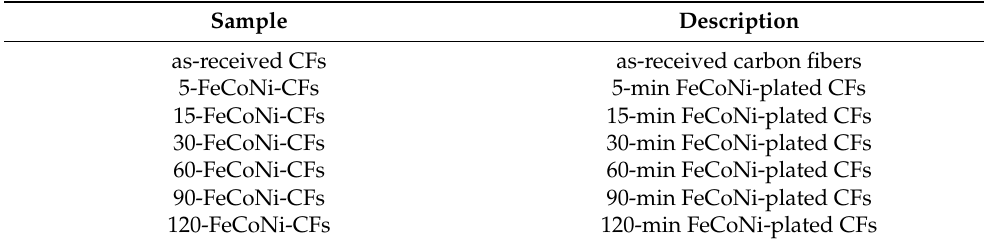
Table 2. Descriptions of the samples.